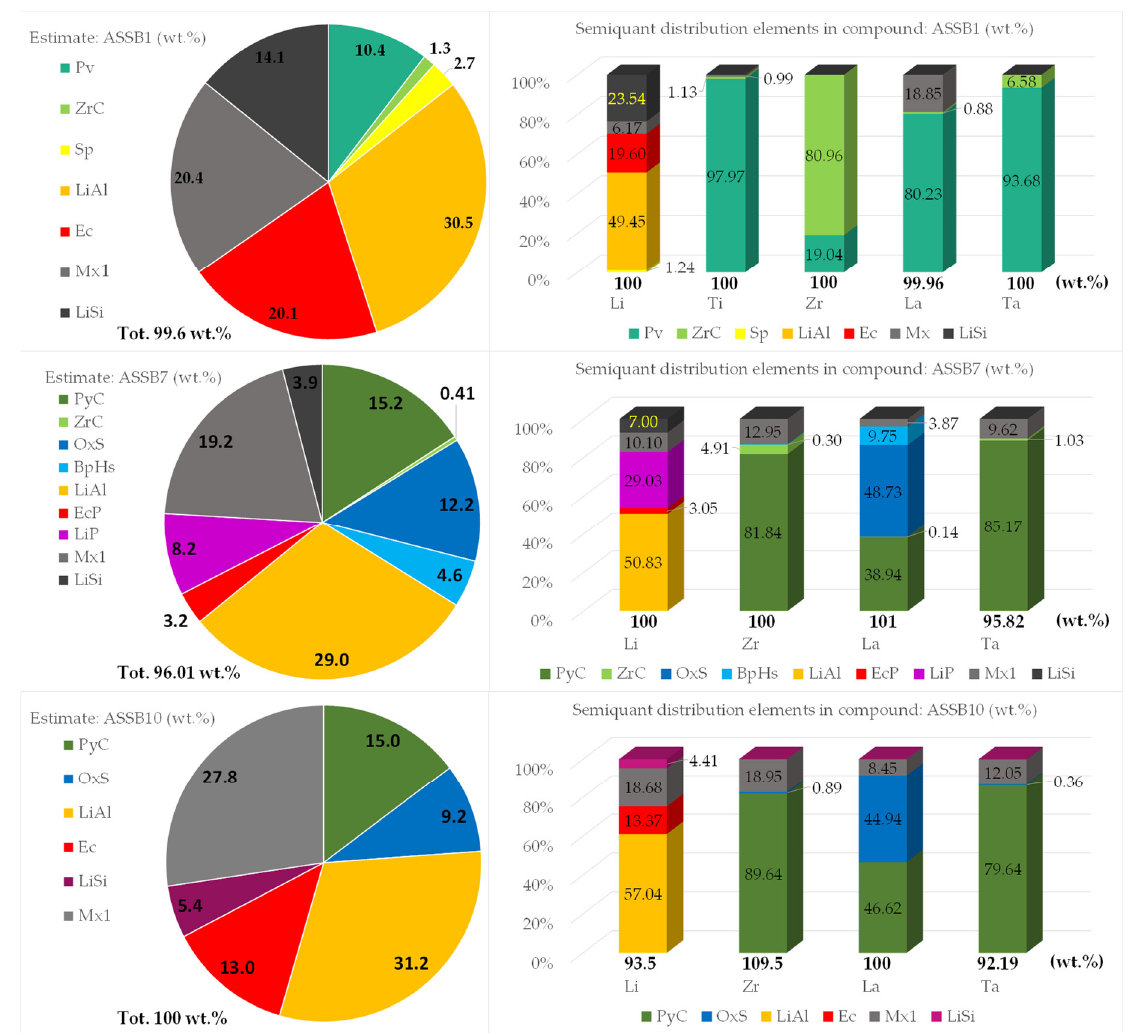
Figure 12. Phase compositions and distributions of elements among the main phases of the samples, ASSB-1, ASSB-7, and ASSB-10. The LiSi (dark grey) in ASSB-1 and ASSB-7 are virtual compounds (Li 2 Si 2 O 5 ) that belong more to the matrix. The LiSi (violet, (Li 2 Al 2 SiO 6 )) in ASSB-10 is derived from real measurements.